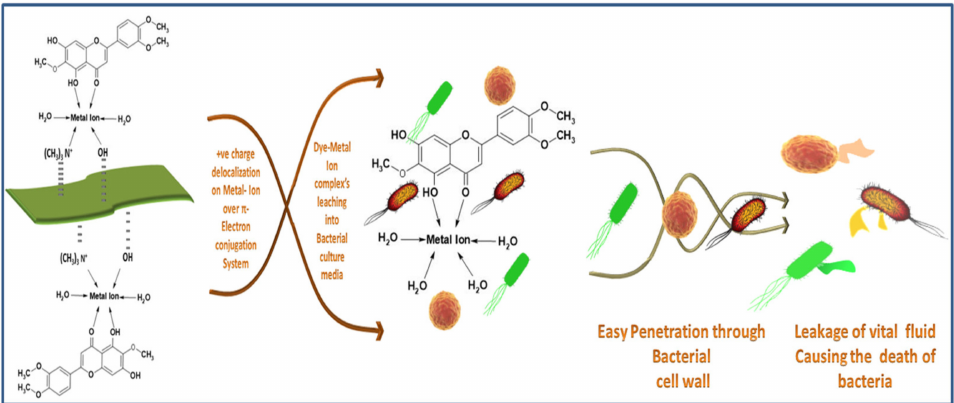
Figure 11. Antibacterial mechanism of the Dye–Metal